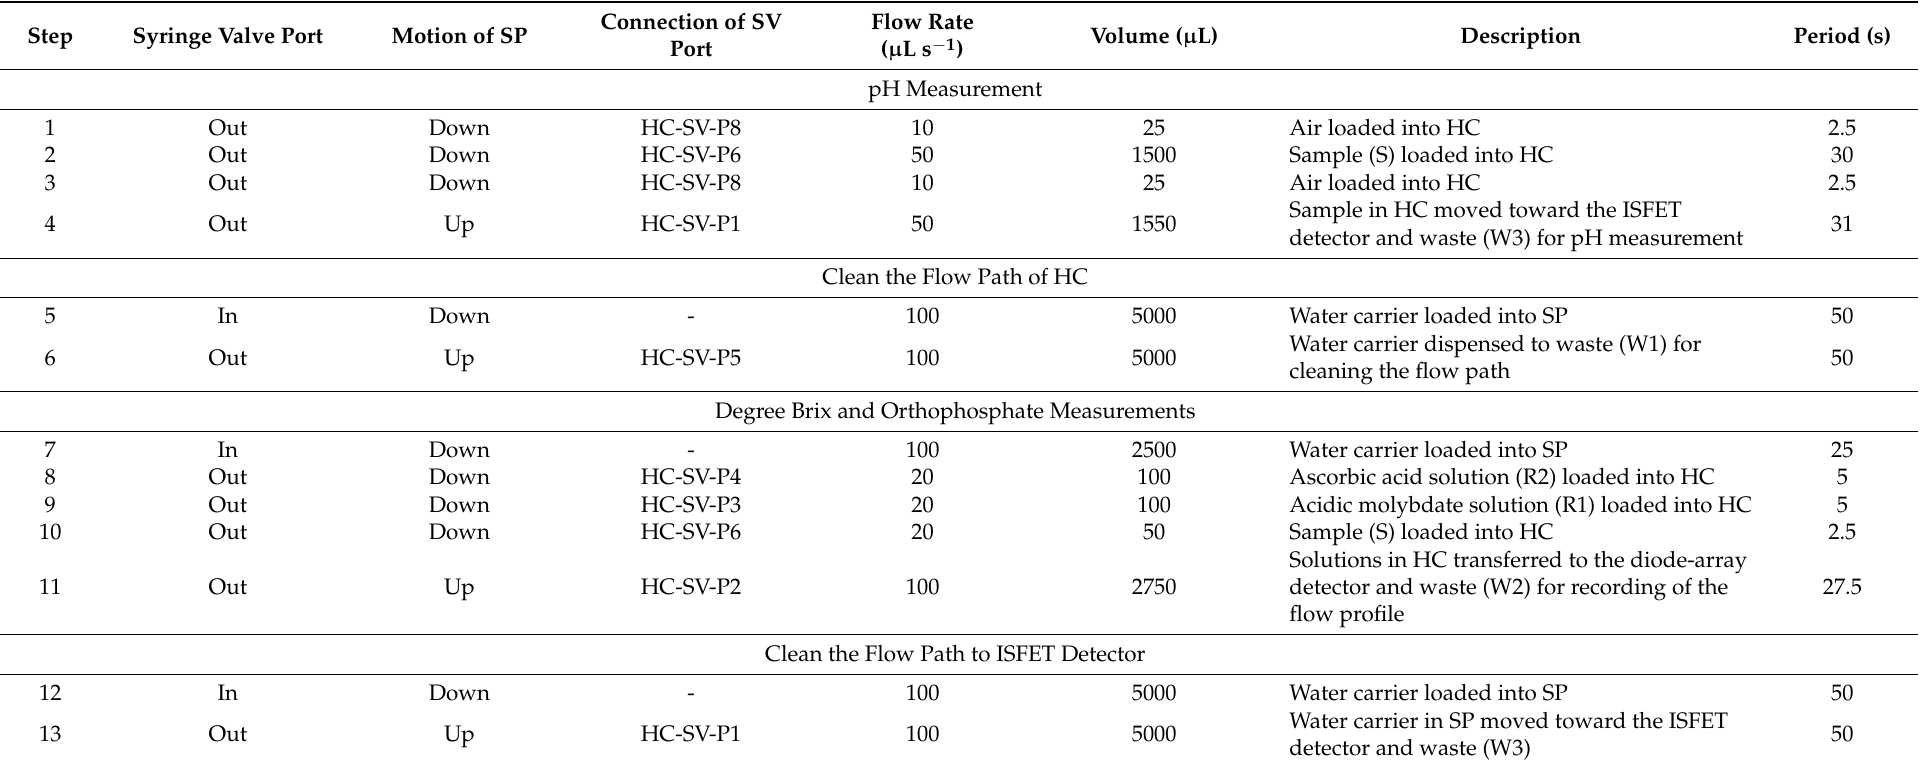
Table 1. Operational step for the SIA system shown in Figure 1 for analysis of pH, ◦ Bx and orthophosphate in sugarcane